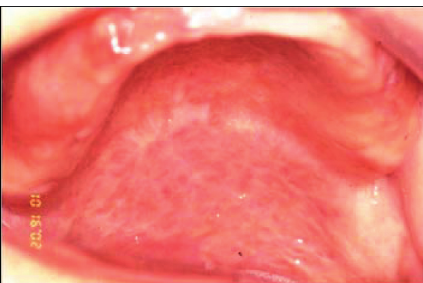
Figure 7: Clinical appearance after treatment with